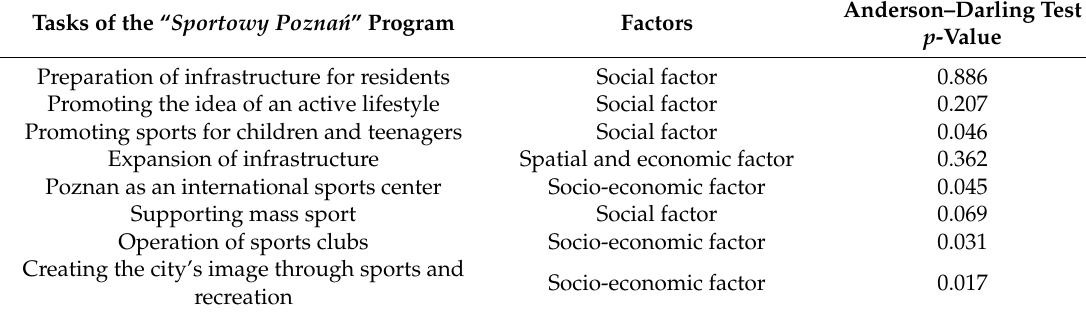
Table 7. Values of the Anderson–Darling test—hierarchy of factors determining the development of sports and recreation